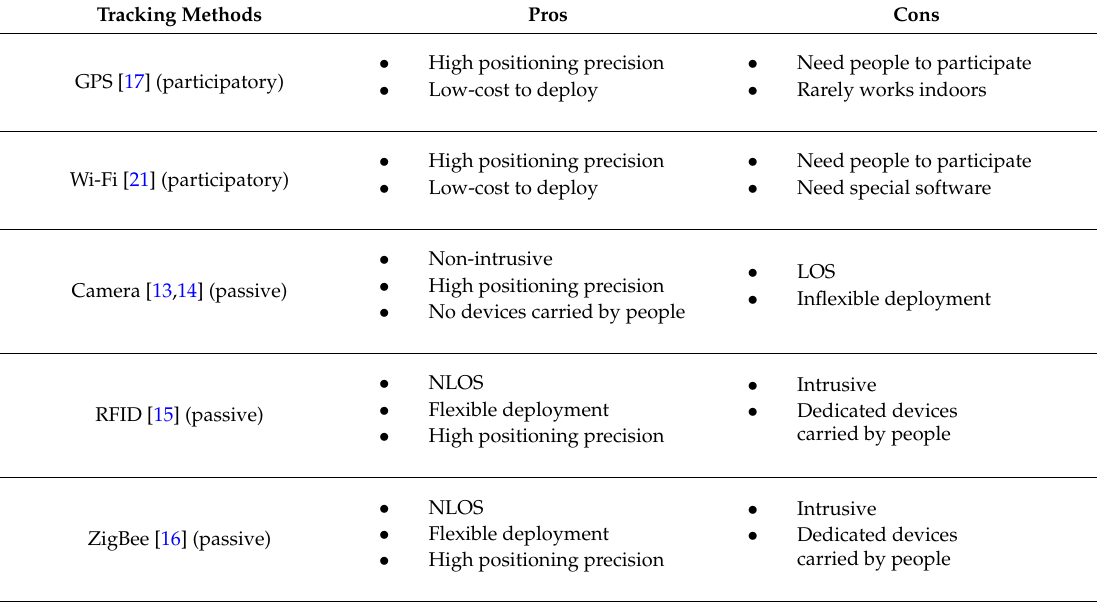
Table 1. Comparison between different people tracking